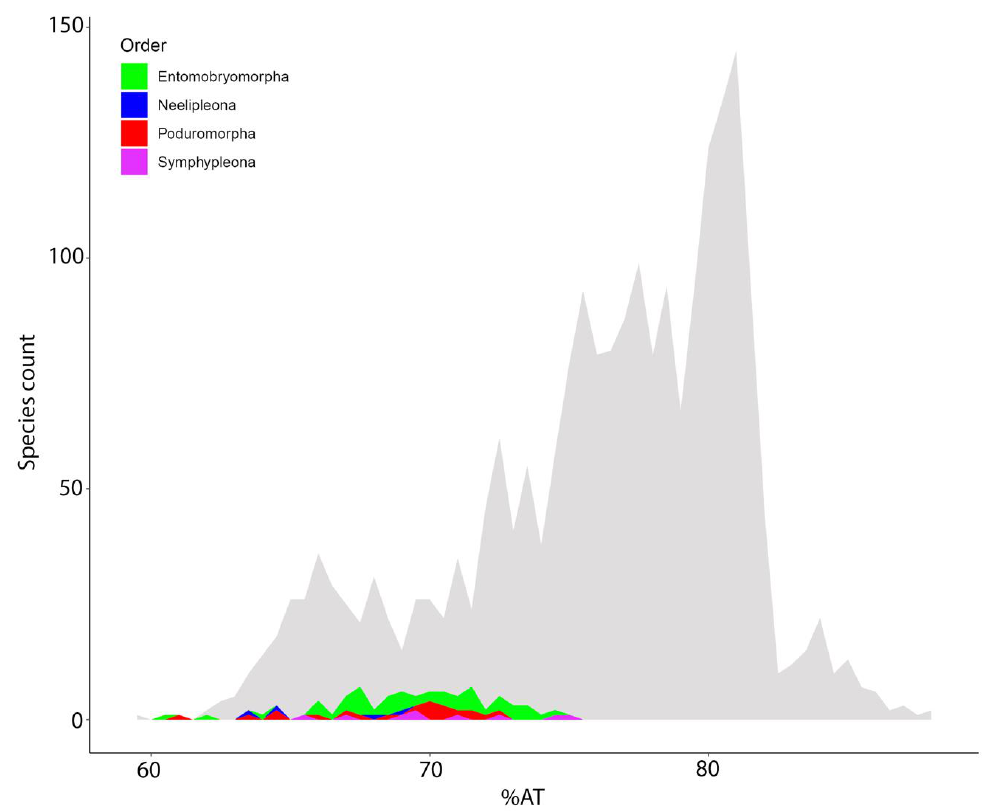
Figure 5. AT% bias within Hexapoda mitogenomes. Collembola genomes are color-coded against a grey background representing the entire Hexapoda dataset.